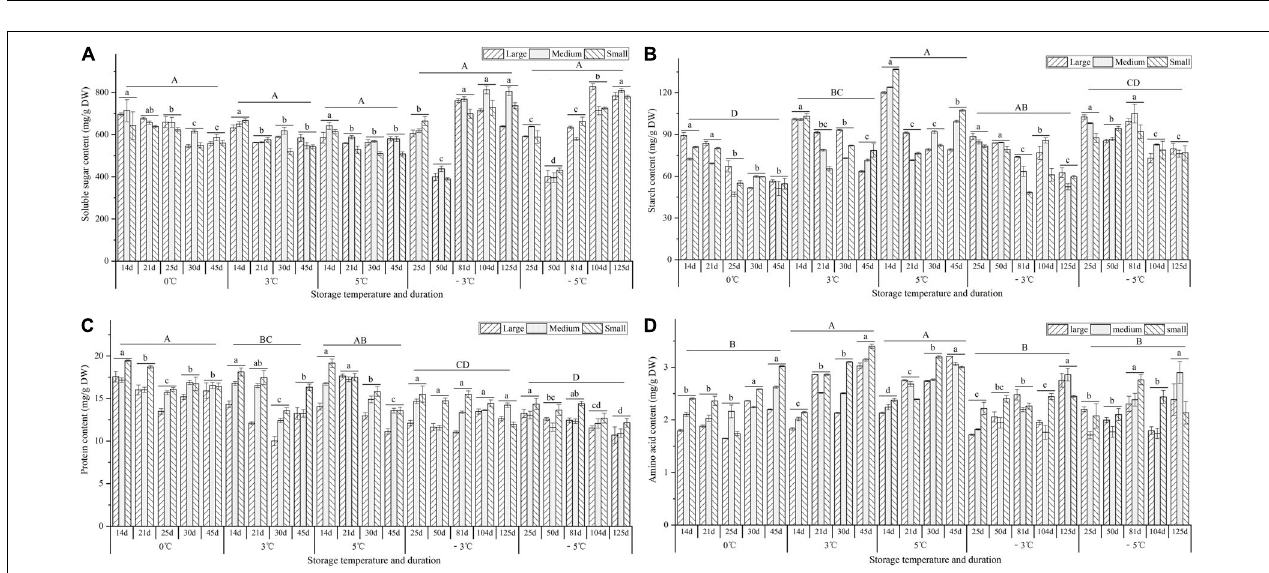
FIGURE 7 | Changes in the root activity of seedlings at different storage temperatures and durations. n = 10 per stage for the different size seedlings. Different uppercase letters represent a significant difference ( P < 0.05) in the average value of different seedlings and storage durations among different temperatures. Different lowercase letters represent a significant difference in the average value of different seedlings between the storage durations for the same temperature.